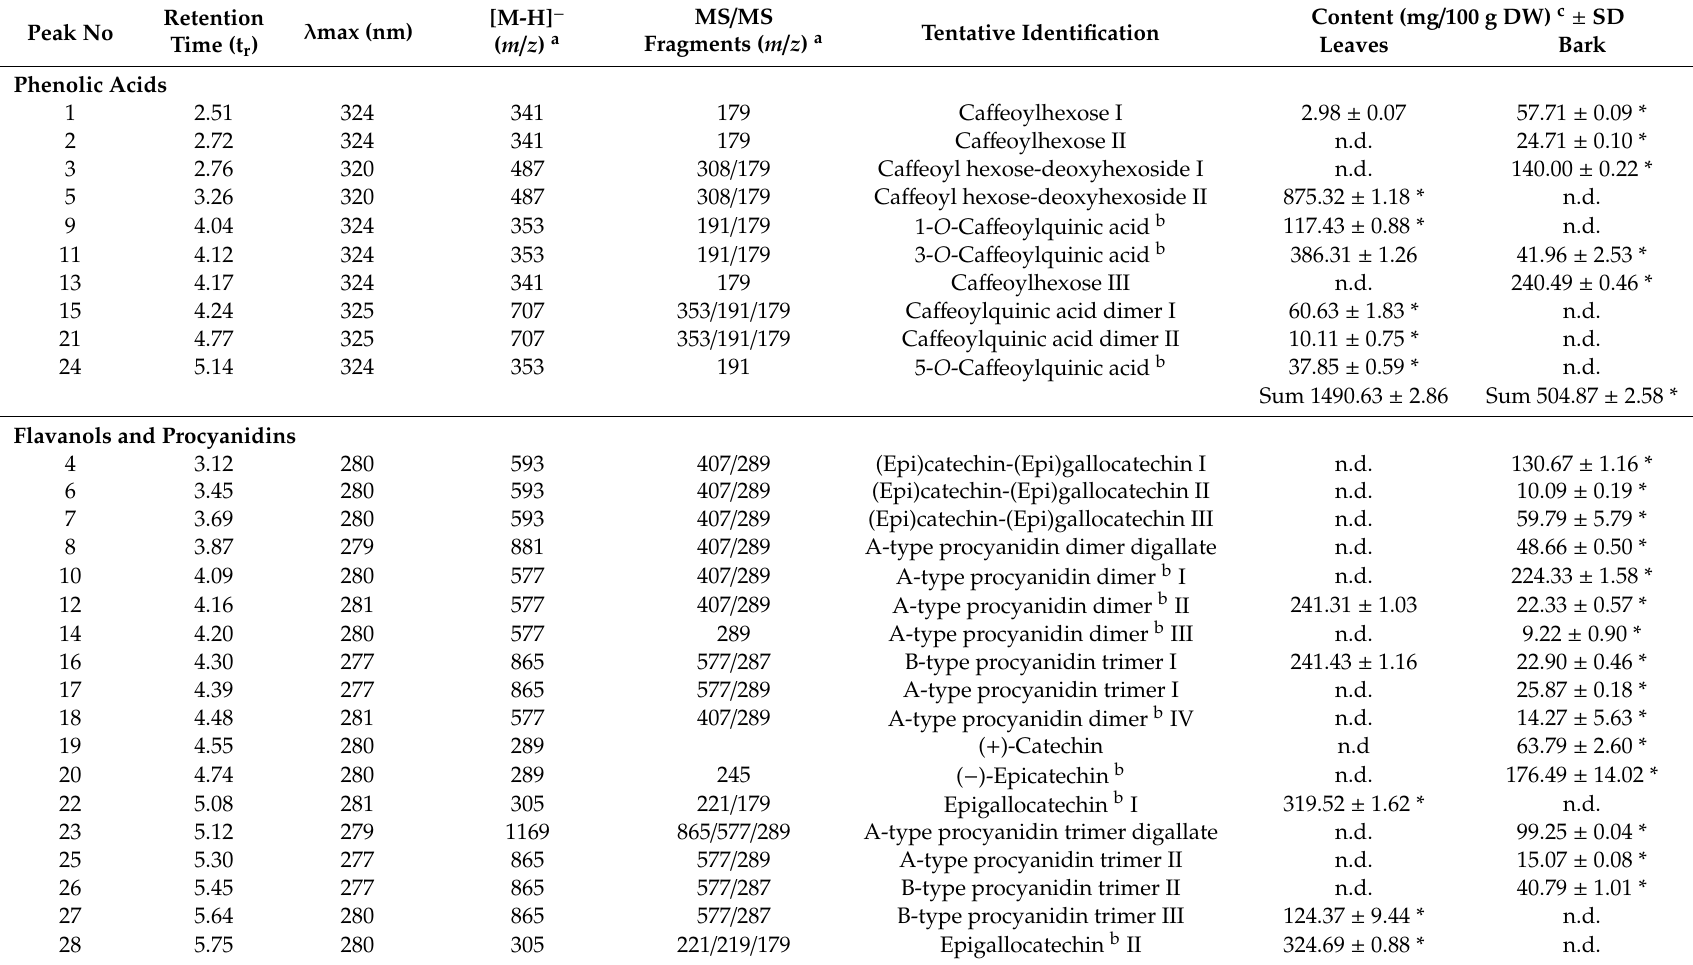
Table 1. Characteristic ions and phenolic compounds content in Salix alba hydromethanolic leaf and bark extracts (mg / 100 g DW) by UPLC-PDA-Q / TOF-MS. Peak